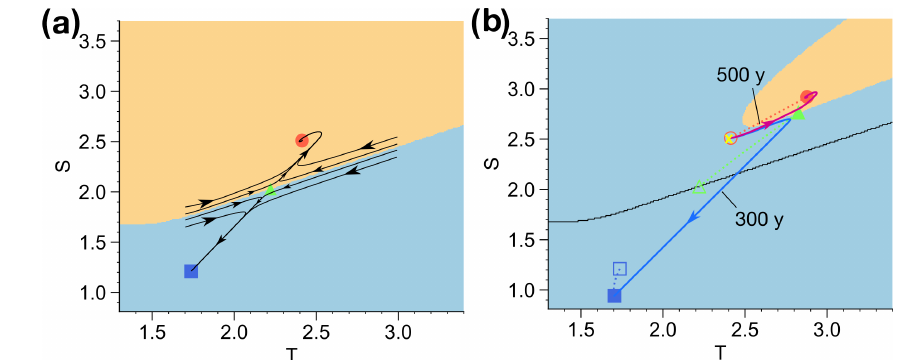
Figure 5. Phase portraits of the Stommel model with basins of attraction and fixed points. Squares and dots indicate stable fixed points, and triangles denote saddle points. (a) Phase portrait for η 1 = 2 . 65 with several flow lines to indicate the dynamics around the saddle. The basin of attraction of the off (on) state is shaded in orange (blue). (b) Phase portrait for η 1 = 3 . 0. Two trajectories where η 1 is ramped linearly from η 1 = 2 . 65 to η 1 = 3 . 0 within 300 and 500 years are shown in blue and purple, respectively. The initial conditions T,S = (2 . 4 , 2 . 5) are indicated by the yellow cross. Open symbols indicate the positions of the fixed points at η 1 = 2 . 65, and the black curve indicates the corresponding basin boundary from (a) .